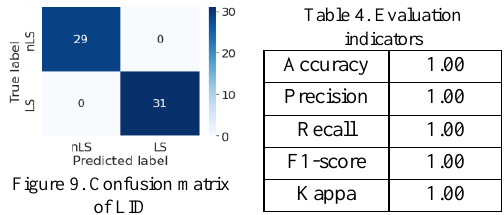
Figure 9. Confusion matrix of LID